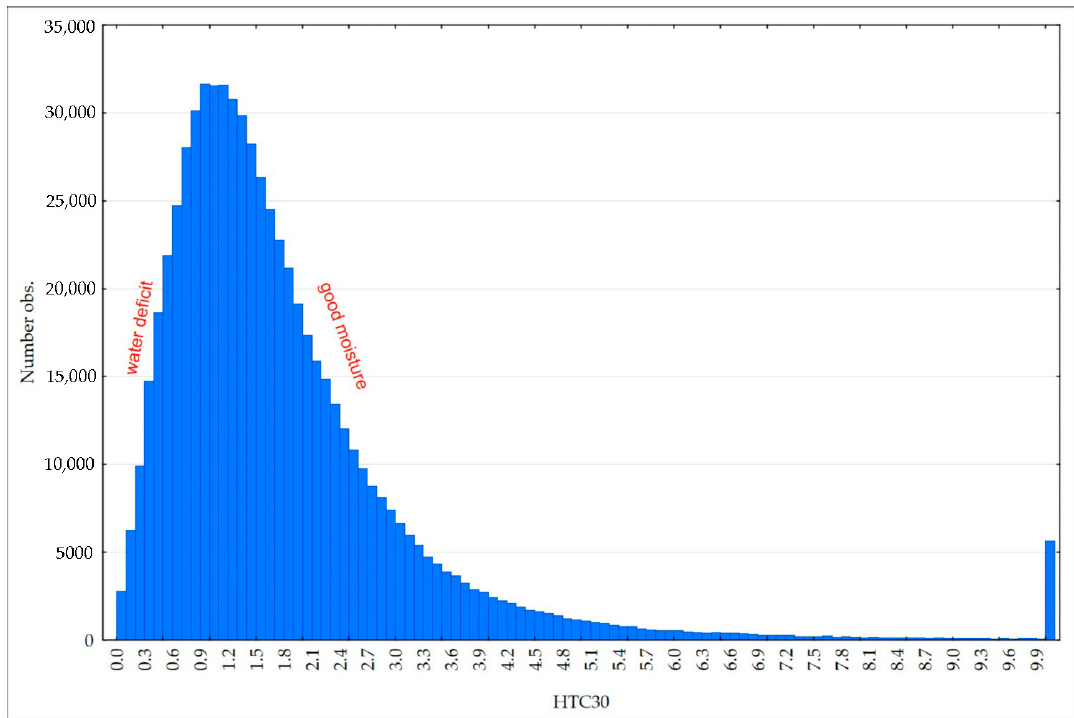
Figure 5. Distribution of HTC30 values for the entire territory of Poland from 2001 to 2019. Remote Sens. 2020 , 12, x; doi: FOR PEER REVIEW